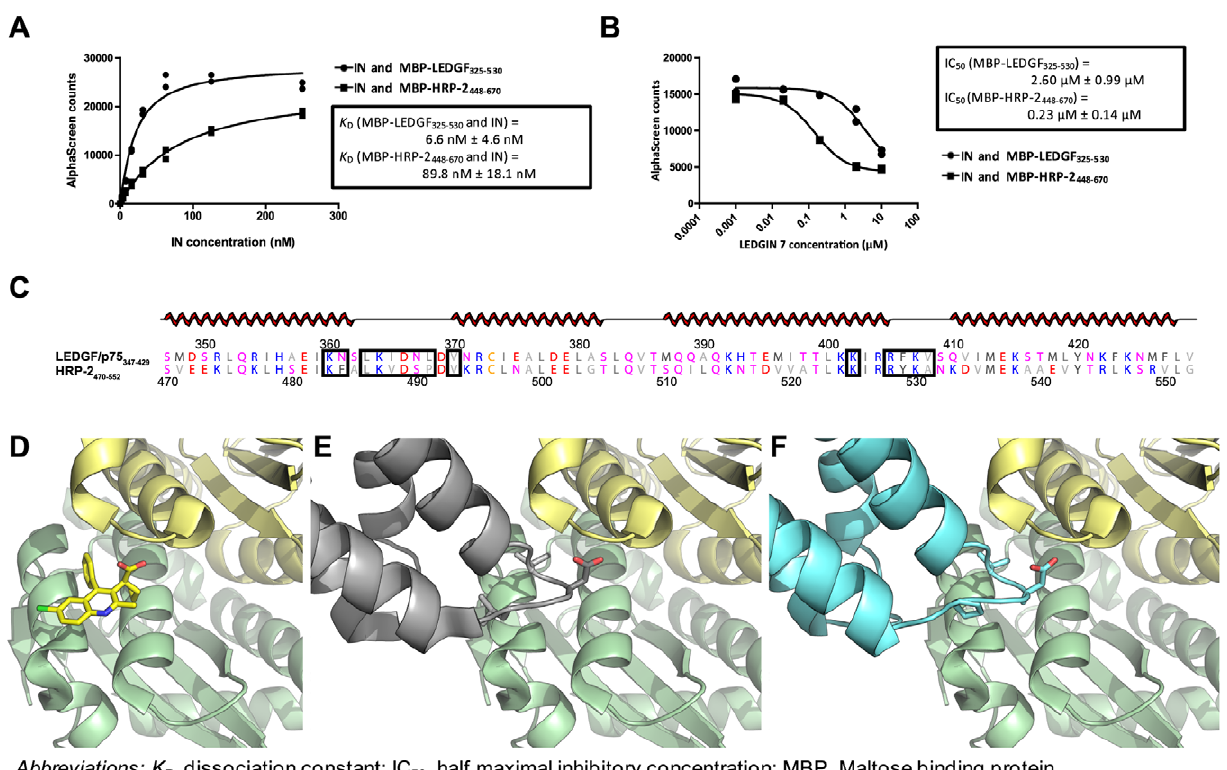
Figure 6. LEDGINs block the interaction of HIV-1 IN with the IBD of either LEDGF/p75 or HRP-2. (A,B) Interactions between His 6 -tagged IN and MBP-LEDGF 325–530 or MBP-HRP-2 448–670 were assessed using AlphaScreen technology. (A) 10 nM MBP-LEDGF 325–530 (circles) or MBP-HRP- 2 448–670 (squares) was incubated with various concentrations of IN (2-fold dilutions from 500 to 1.9 nM). Anti-MBP donor and Ni 2 + -chelate acceptor beads were added and the AlphaScreen signal was read on an EnVision Multilabel reader. Boxed data show average apparent K D values 6 S.E.M. for the IN-MBP-LEDGF 325–530 or IN-MBP-HRP-2 448–670 interaction as determined from four independent experiments, each performed in duplicate. A representative experiment is shown. (B) MBP-LEDGF 325–530 or MBP-HRP-2 448–670 (10 nM) was incubated with IN (500 nM) and various concentrations of LEDGIN 7 (10, 2, 0.2, 0.02 and 0 m M, the latter plotted as 0.001 m M). Again, beads were added and the plate was read as described. Boxed data show IC 50 values of LEDGIN 7 on the interaction of IN with MBP-LEDGF 325–530 or MBP-HRP-2 448–670 . Average IC 50 values 6 standard deviations were derived from three independent experiments each performed in duplicate. A representative experiment is shown. In (C–F) the homology of LEDGF/ p75 IBD and HRP-2 IBD and their interaction with IN is shown. (C) Alignment of LEDGF/p75 347–429 and HRP-2 470–552 . Amino acids are colored by type and secondary structure is depicted on top ( a -helices in red). Residues involved in the interaction with IN catalytic core domain are boxed. Alignments were generated with ClustalW [63] and further visualized in ALINE [64]. (D–F) Cartoon representations of the IN catalytic core domain (CCD) dimer (pale green and pale yellow) with (D) LEDGIN 6 (sticks, colored by atom), (E) LEDGF/p75 IBD (gray) or (F) HRP-2 IBD (cyan). Side chains of the crucial amino acids, mimicked by LEDGINs, i.e. residues I365, D366, L368 of LEDGF/p75, and corresponding HRP-2 residues V488, D489 and P491, are shown in sticks colored by atom. Structures of LEDGF/p75 IBD in complex with IN CCD dimer were taken from PDB ID: 2B4J [65]. HRP-2 IBD homology models were built with MODELLER [66], based upon the same LEDGF/p75 IBD – IN CCD dimer structure. The structure of the LEDGIN 6 – IN CCD dimer complex was taken from PDB ID: 3LPU [25]. All structures were visualized in PyMol (DeLano Scientific LLC, Palo Alto,